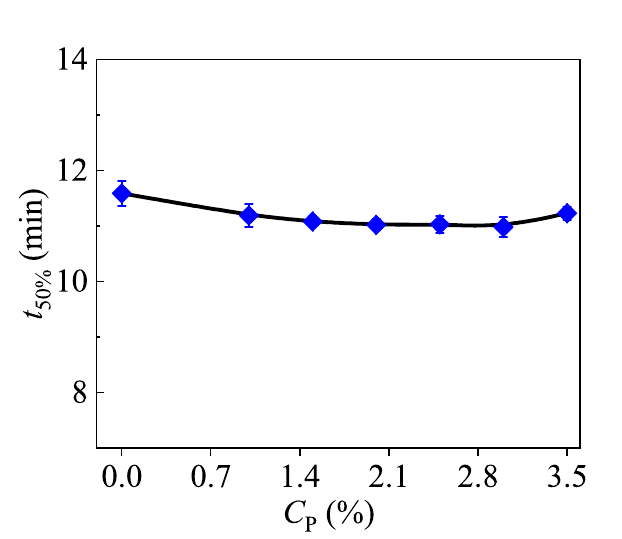
Figure 2. The function curve of the half-life of the foam with respect to the concentration of the magnetic